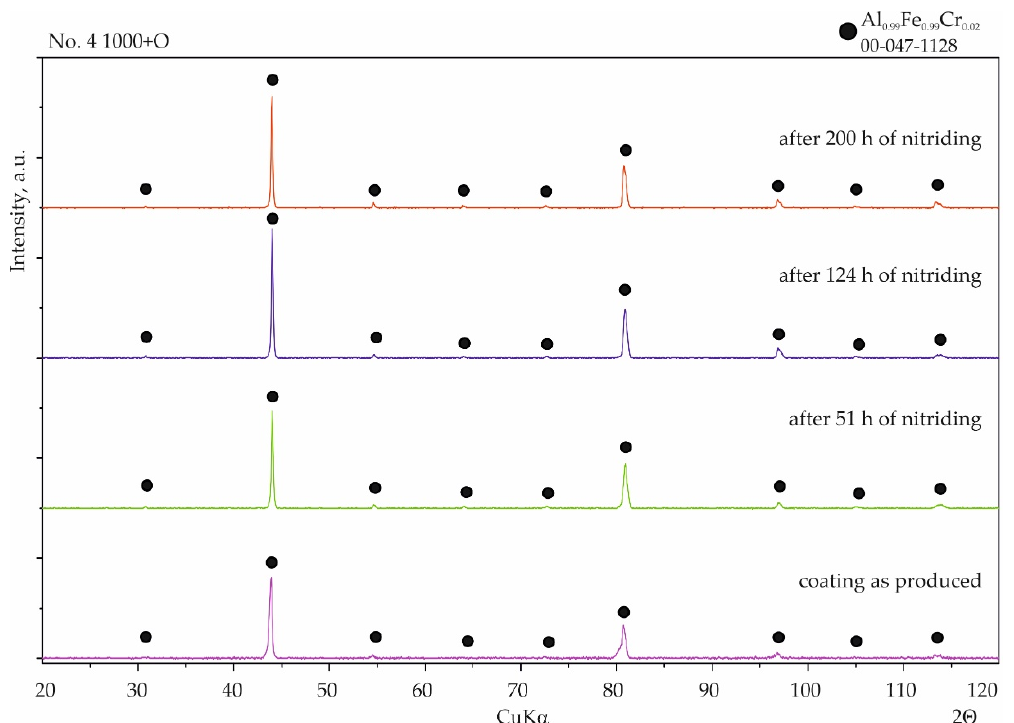
Figure 13. Qualitative X-ray structure analysis (XRD) of the Al–Si coating on 1.4541 steel produced at 1000 °C and 2 h with additional oxidation in 1000 °C during 5 min; from the bottom: in the initial state; after 51 h of nitriding; after 124 h of nitriding; and after 200 h of nitriding.